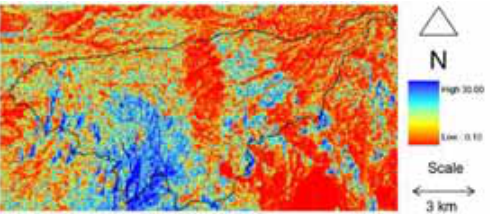
Fig 12: Roughness map (Lc in cm) derived from radar images by the use of IEM, as formulated in Eq. (4). The solid line represents; the boundary of USDA ARS Walnut Gulch Experimental Watershed Rehman et al